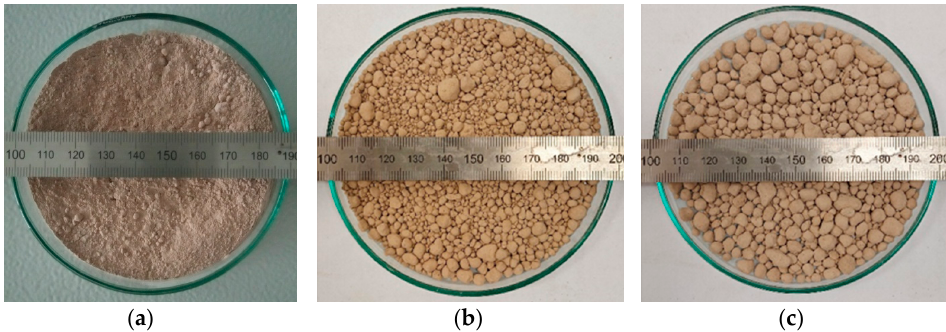
Figure 4. Raw material ( a ) pan ( b ) and product ( c ) samples of the granulation.